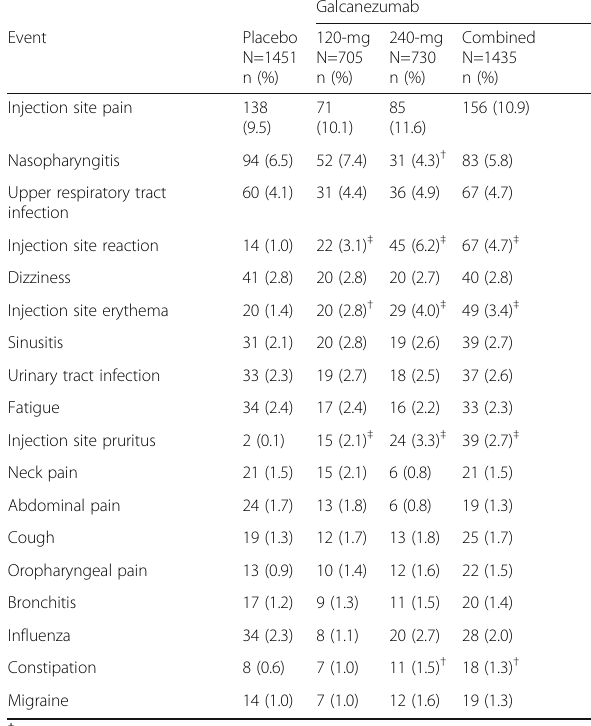
Table 1 (abstract P70). Treatment-emergent adverse events reported by 1.5% or more patients in any galcanezumab